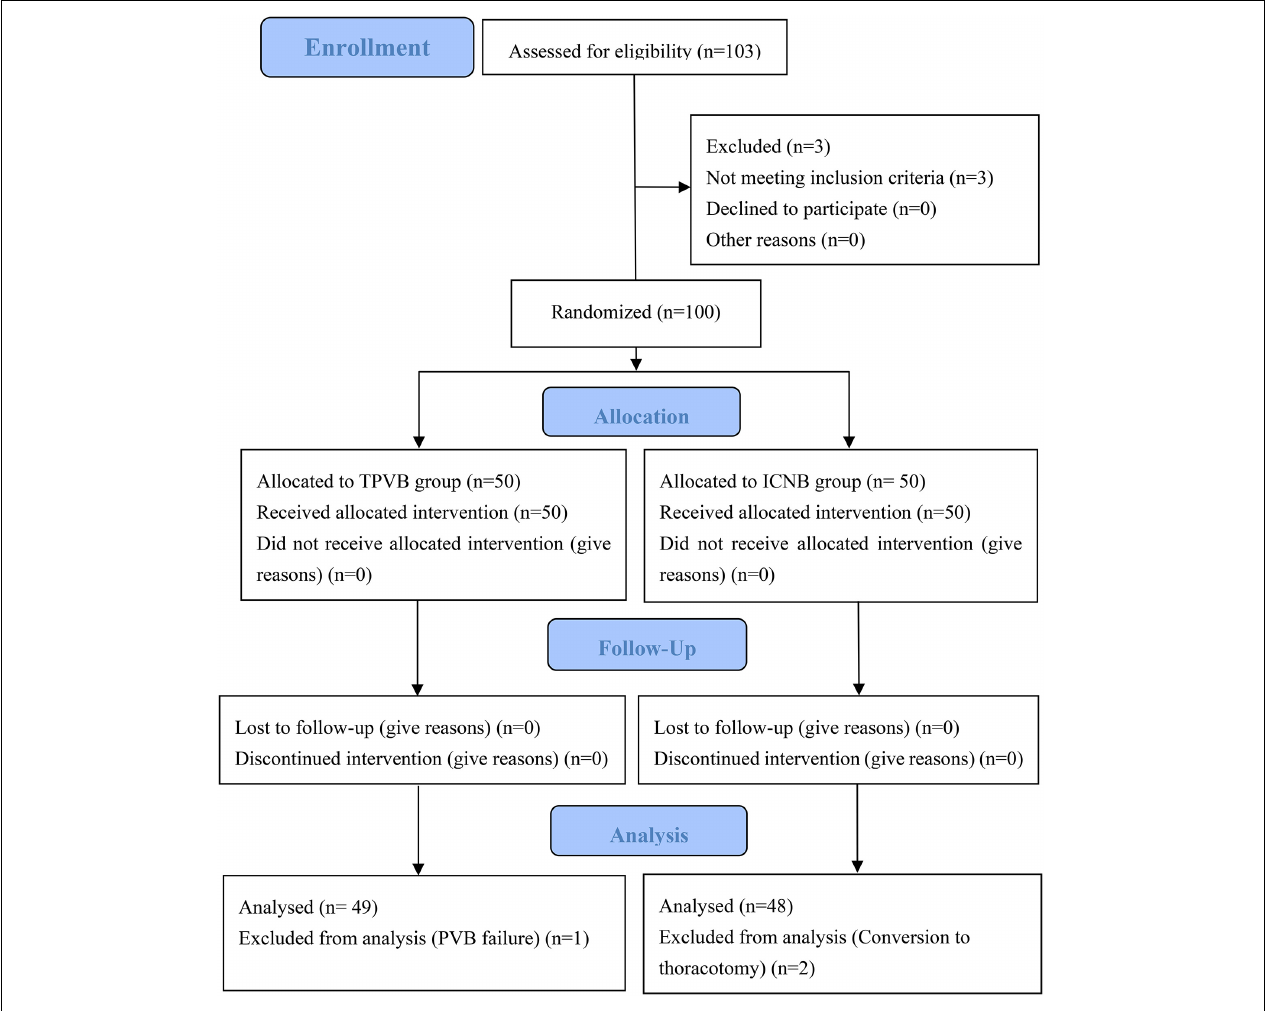
FIGURE 1 | CONSORT flow diagram. TPVB indicates thoracic paravertebral blocks, and ICNB indicates intercoastal nerve